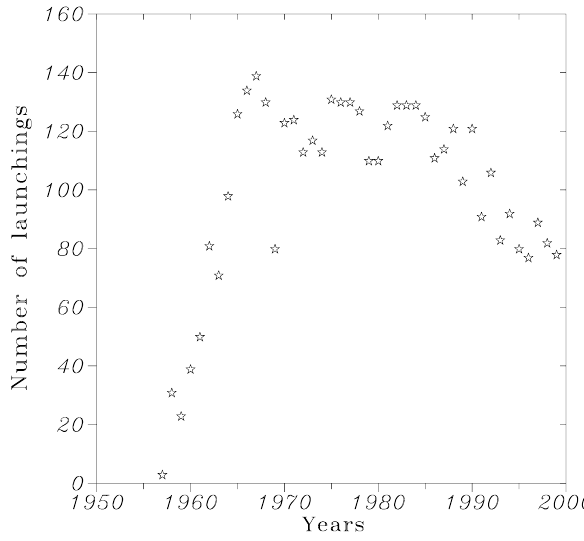
Fig. 5. Total number of rocket launchings during the 1957–1999